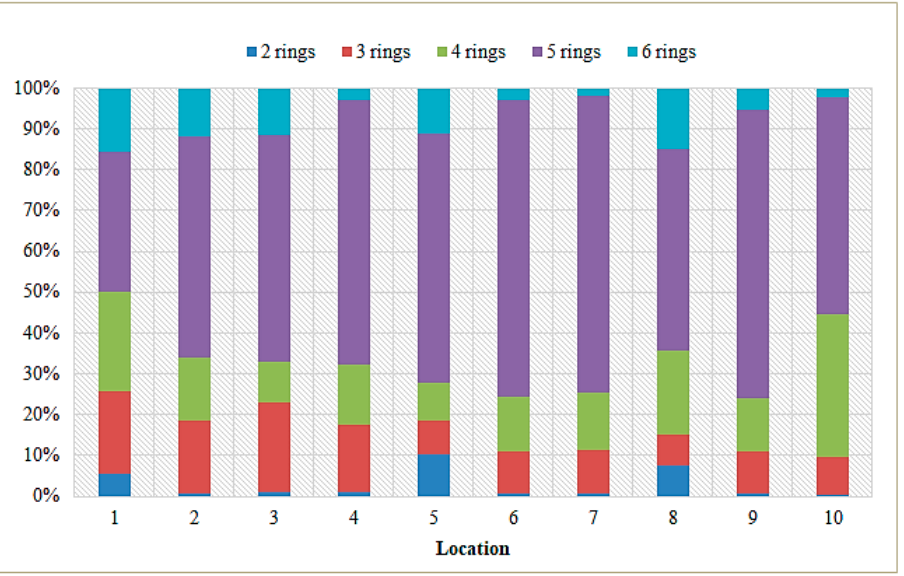
Figure 6. Composition profile of total PAHs in sediment samples from the Sele